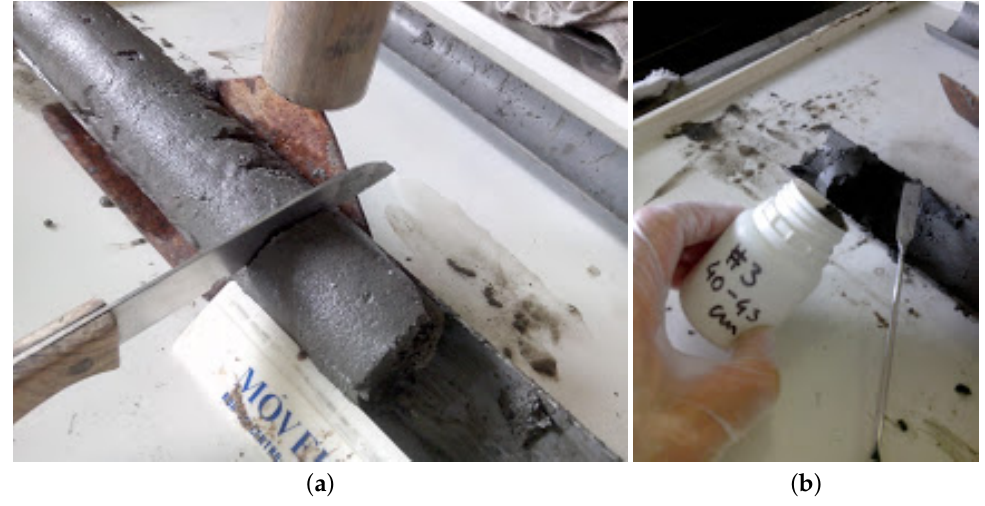
Figure 21. Sample collected by the robotic system being post-processed in the lab. ( a ) The sample in its PVC case; ( b ) profile layers are kept for further